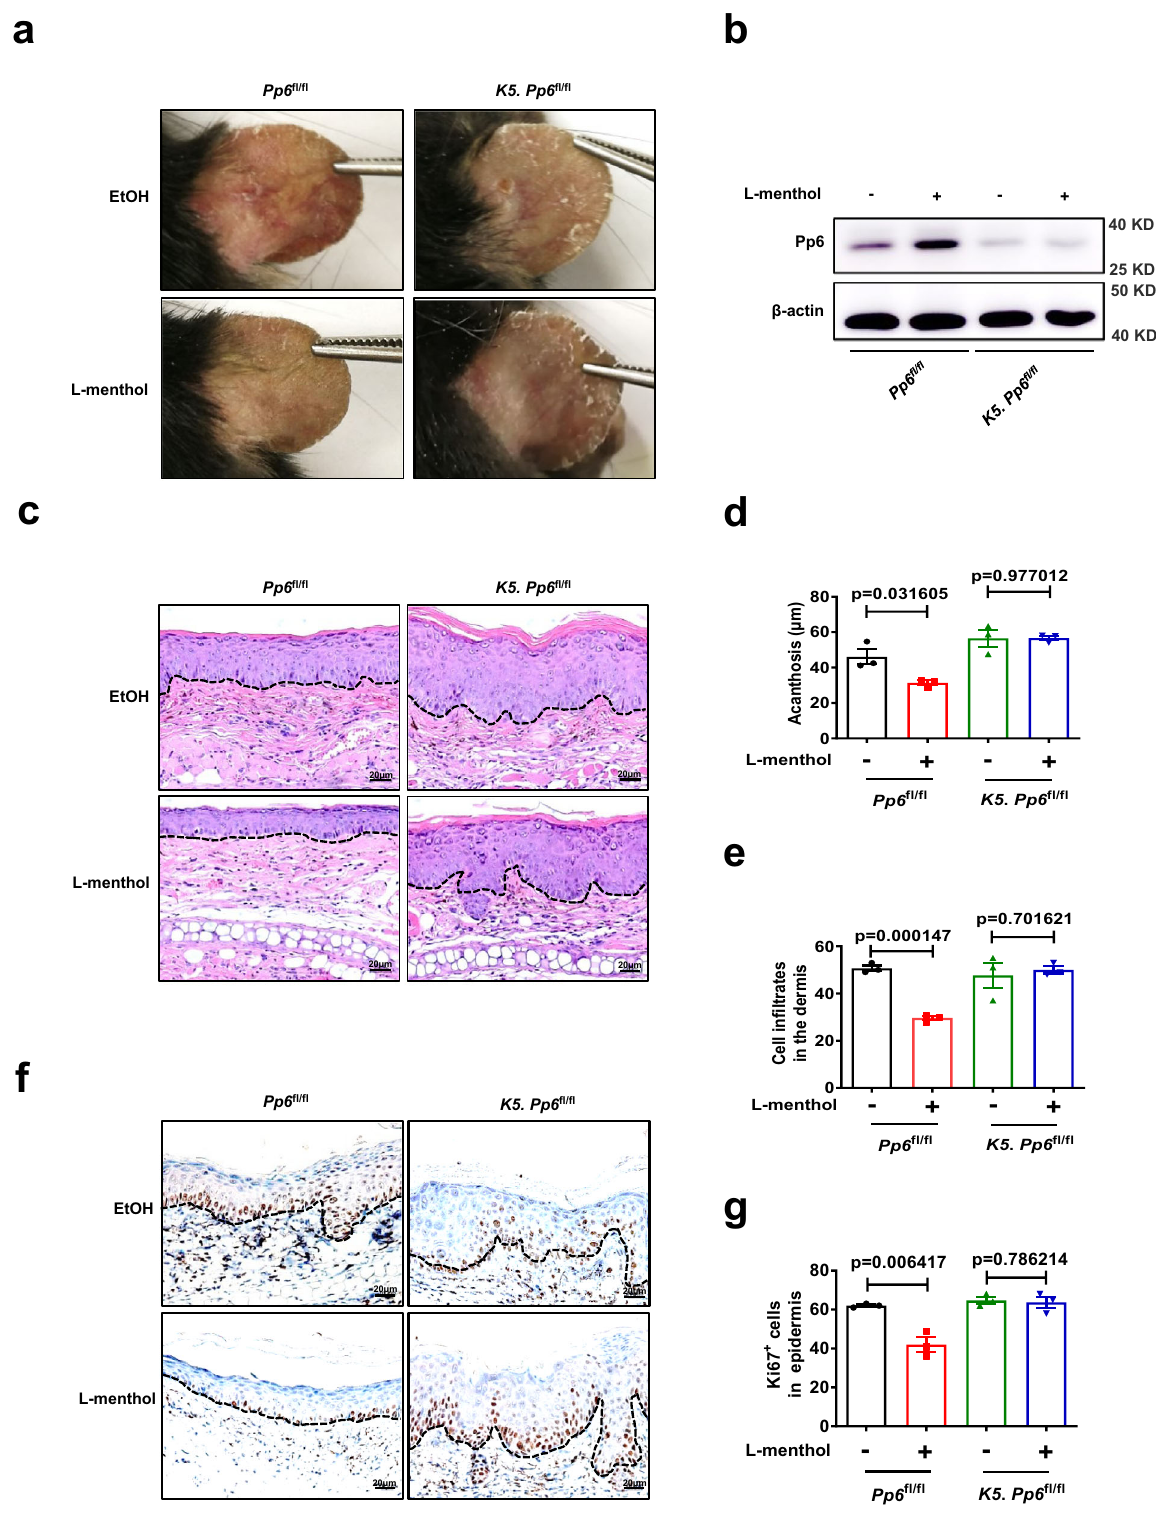
Fig. 2 | The anti-in fl ammation effects of L -menthol are mediated by Pp6 in keratinocytes. a Representative photographs of the ears of IMQ-induced Pp6 fl / fl mice and K5. Pp6 fl / fl mice treated with EtOH or 50 μ g/day L-menthol ( n =3). b Immunoblotting analysis of Pp6 expression in the epidermis derived from IMQ- induced Pp6 fl / fl mice and K5. Pp6 fl / fl mice treated with EtOH or 50 μ g/day L -menthol. c Representative H&E staining of the ears treated as in( a ) ( n =3).Scalebar, 20 μ m. d , e Acanthosis ( d ) and dermal cellular in fi ltrates ( e ) of ears derived from IMQ-